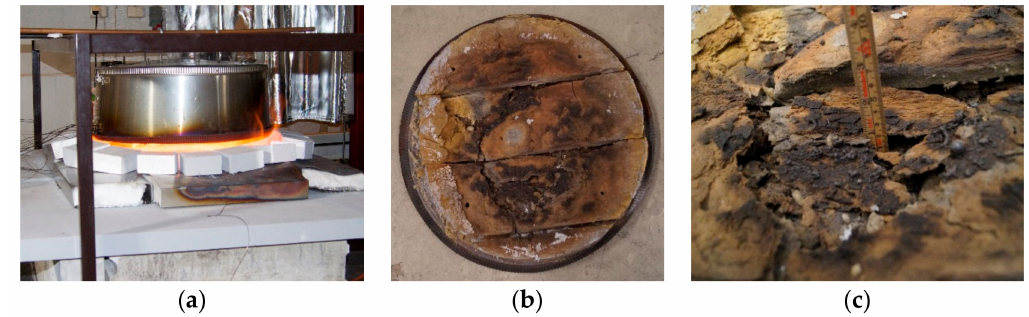
Figure 1. Small-scale jet-fire test setup ( a ), exposed thermal insulation after the jet fire testing ( b )